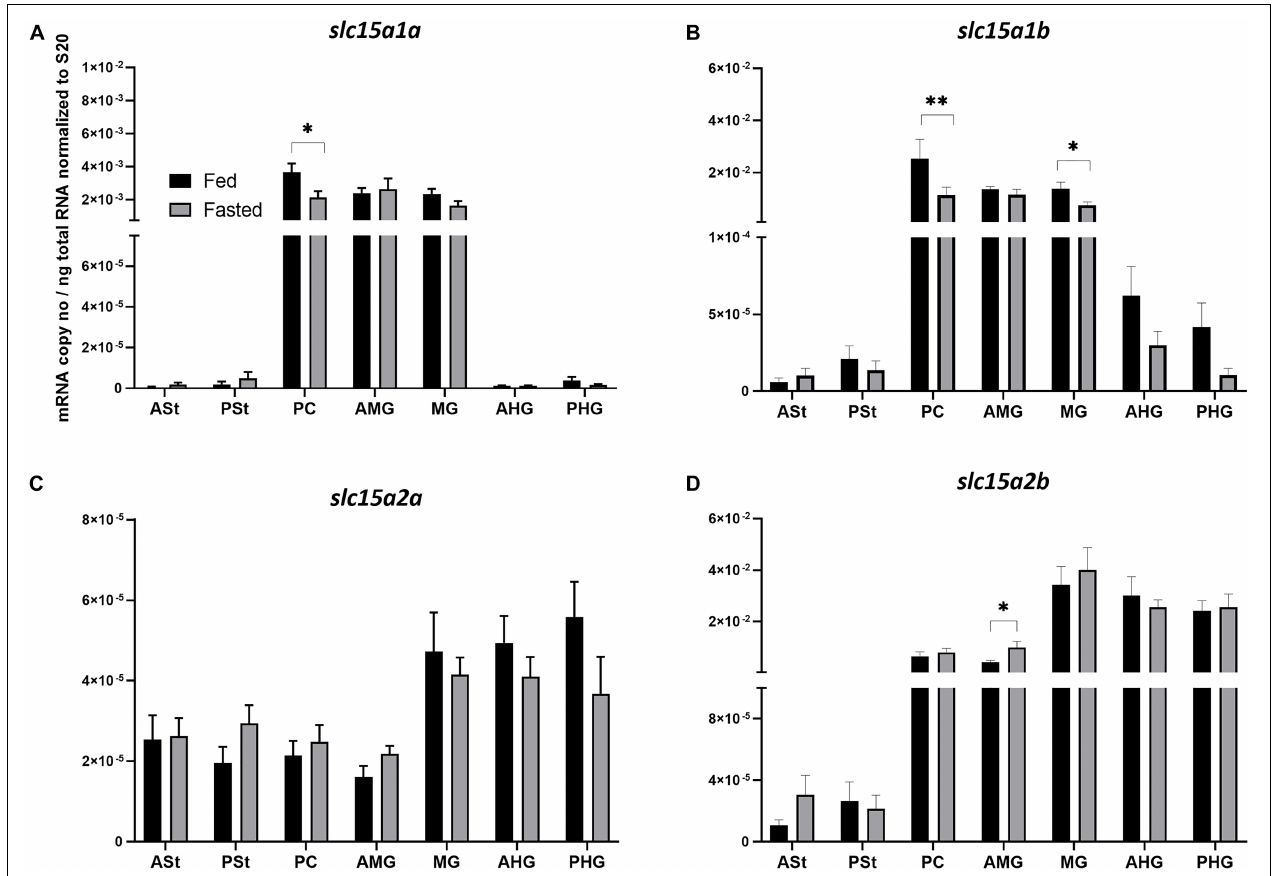
FIGURE 1 | Comparison of mRNA expression levels of (A) slc15a1a , (B) slc15a1b , (C) slc15a2a , and (D) slc15a2b between fed (control) and 4-day fasted groups along the gastrointestinal tract. (A) Data are presented as mean ± SE [ n = 12 per group, except for PSt fed and fasted, PC fed, AMG fed, MG fed, and AHG fed ( n = 11); ASt fasted ( n = 9) and ASt fed ( n = 8)] of the normalized expression using the reference gene s20 . (B) Data are presented as mean ± SE [ n = 12 per group, except for ASt fed, PSt fed, PC fasted, MG fed and fasted and PHG fasted ( n = 11), and AMG fed ( n = 10)] of the normalized expression using the reference gene s20 . (C) Data are presented as mean ± SE [ n = 12 per group, except for PSt fed and fasted, PC fed and fasted, AMG fasted and PHG fasted ( n = 11), and AMG fed ( n = 10)] of the normalized expression using the reference gene s20 . (D) Data are presented as mean ± SE [ n = 12 per group, except for PSt fed, AMG fed, MG fasted, AHG fasted and PHG fed and fasted ( n = 11), and PC fasted ( n = 10)] of the normalized expression using the reference gene s20 . Statistical analysis: unpaired t -test (* p < 0.05; ** p < 0.01). ASt, anterior stomach; PSt, posterior stomach; PC, pyloric ceca; AMG, anterior midgut; MG, midgut; AHG, anterior hindgut; PHG, posterior